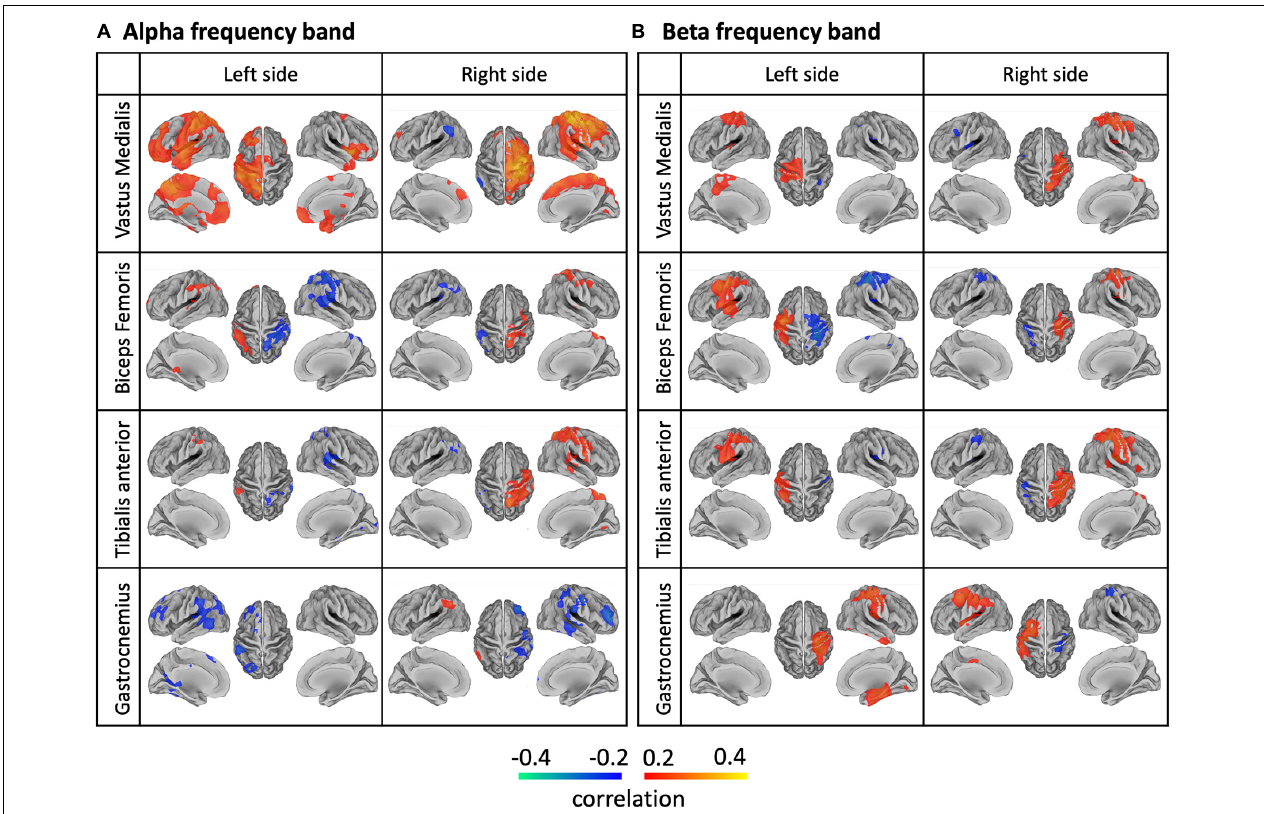
FIGURE 10 | Brain-body connectivity maps for (A) alpha and (B) beta frequency bands, obtained using EMG envelopes. We considered the EMG envelopes for each of the eight body sensors: left/right vastus medialis, biceps femoris, tibialis anterior, gastrocnemius. We used the threshold r > 0 . 2 for visualization